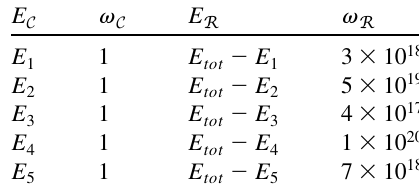
chapter 4 [of Ref. [51] ] and the density of states tutorial